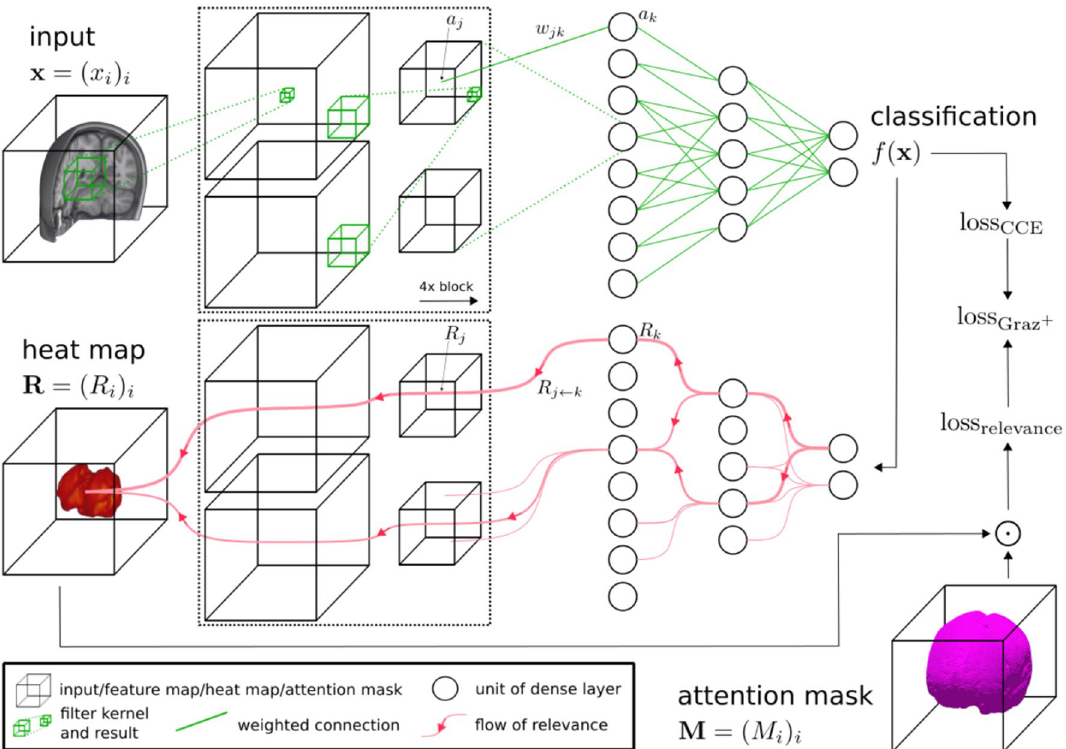
Figure 2. Schematic overview of the Graz + network and the adapted training process. A conventional classifier network (top) is extended by the heat map generator (bottom). For each classifier network layer a corresponding relevance redistribution layer with shared parameters and activations is attached to the generator network. The online calculated heat map is guiding the classifier training by adding a relevance sum inside the binary attention mask ( loss relevance ), which is added to the categorical cross entropy loss ( loss CCE ), yielding the total loss ( loss Graz + ). ⊙ denotes the element-wise product. The solid green lines in the classifier network are the weighted connections between units of the layers, whereas items connected with dashed green lines symbolize information flow from one layer to the following layer (e.g. input to feature map, multiple feature maps to feature map or feature maps to densely connected unit). In contrast, the red lines in the heat map generator indicate the amount of relevance (thickness of line) flowing through the units of the layers to the heat map. If a unit does not contribute to the heat map the flow is